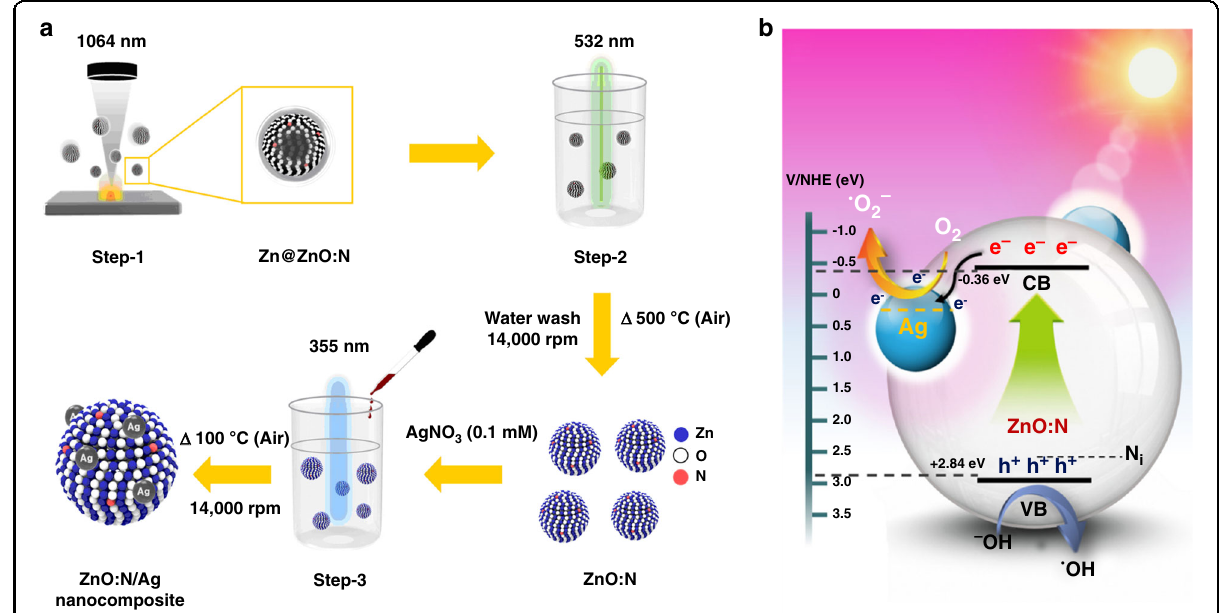
Fig. 16 PLA and PLI process for ZnO based composites. a Schematic illustration of the fabrication of ZnO:N/Ag via two-step PLA and PLI process, and b Photocatalytic degradation mechanism of RhB over ZnO:N/Ag catalyst under solar light 185 . Copyright (2021)